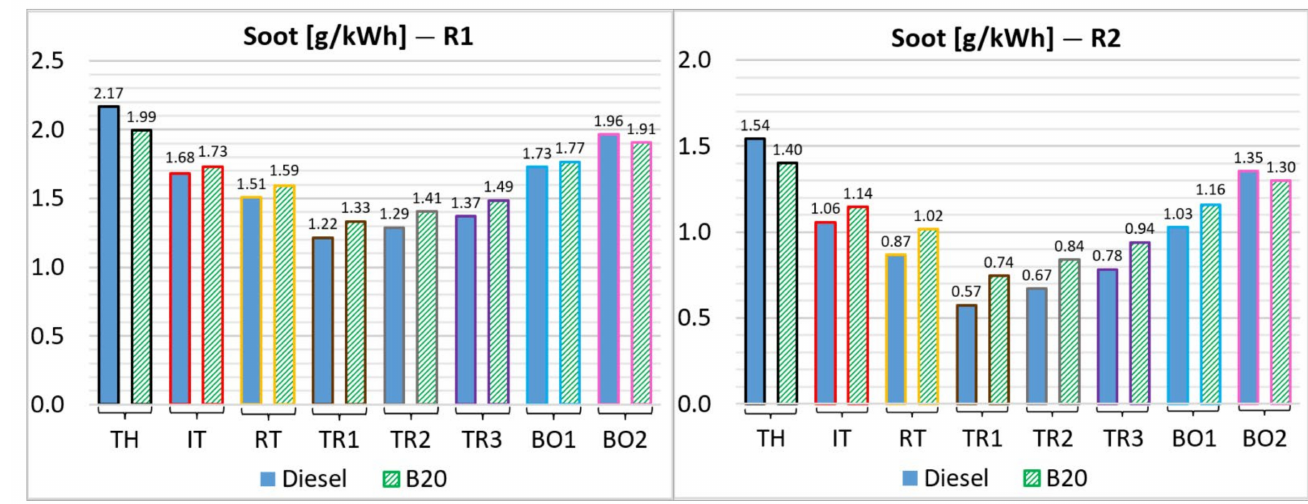
Figure 14. Soot variation by different shapes of ROI. Table 6. The surface area under the ROI shapes calculated between the SOI and MFB10% events.